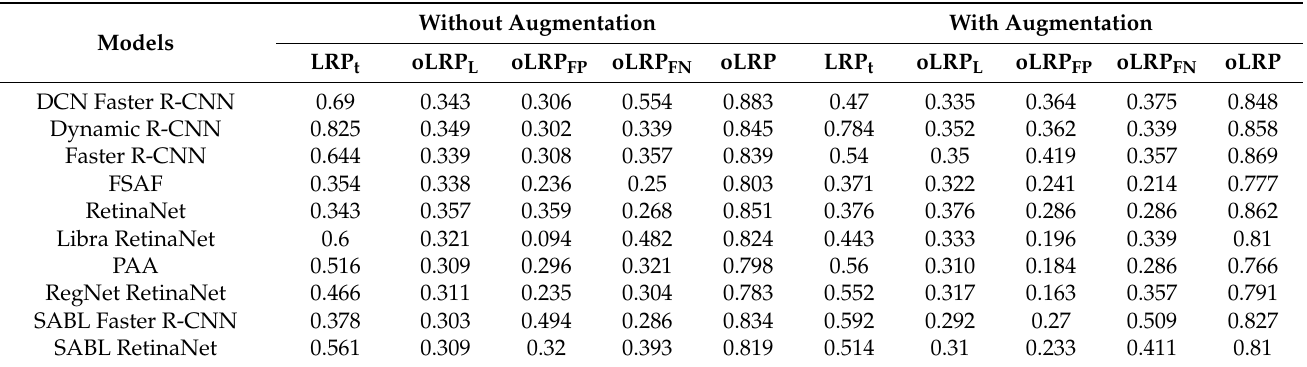
Table 9. Test LRP-optimal threshold (LRPt), oLRP Loc (oLRP L ), oLRP FP and oLRP FN results of detection models.